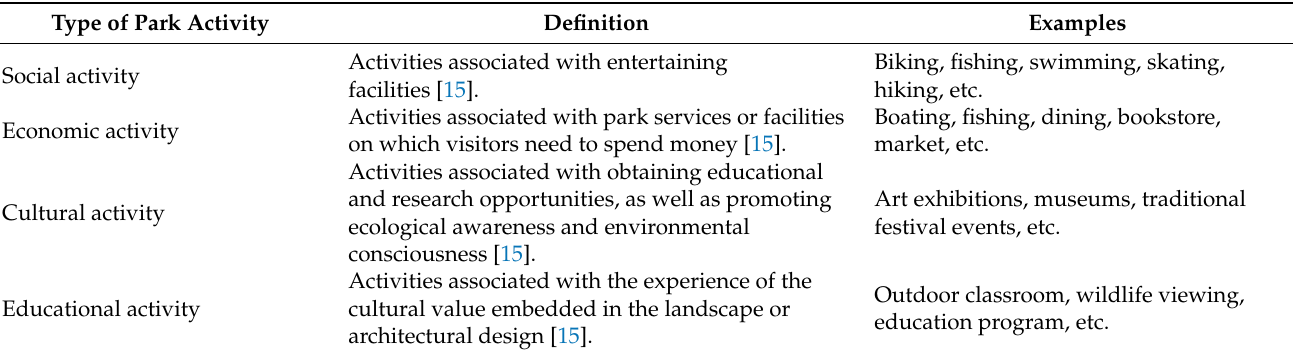
Table 4. Type and examples of outdoor park activity in urban parks.